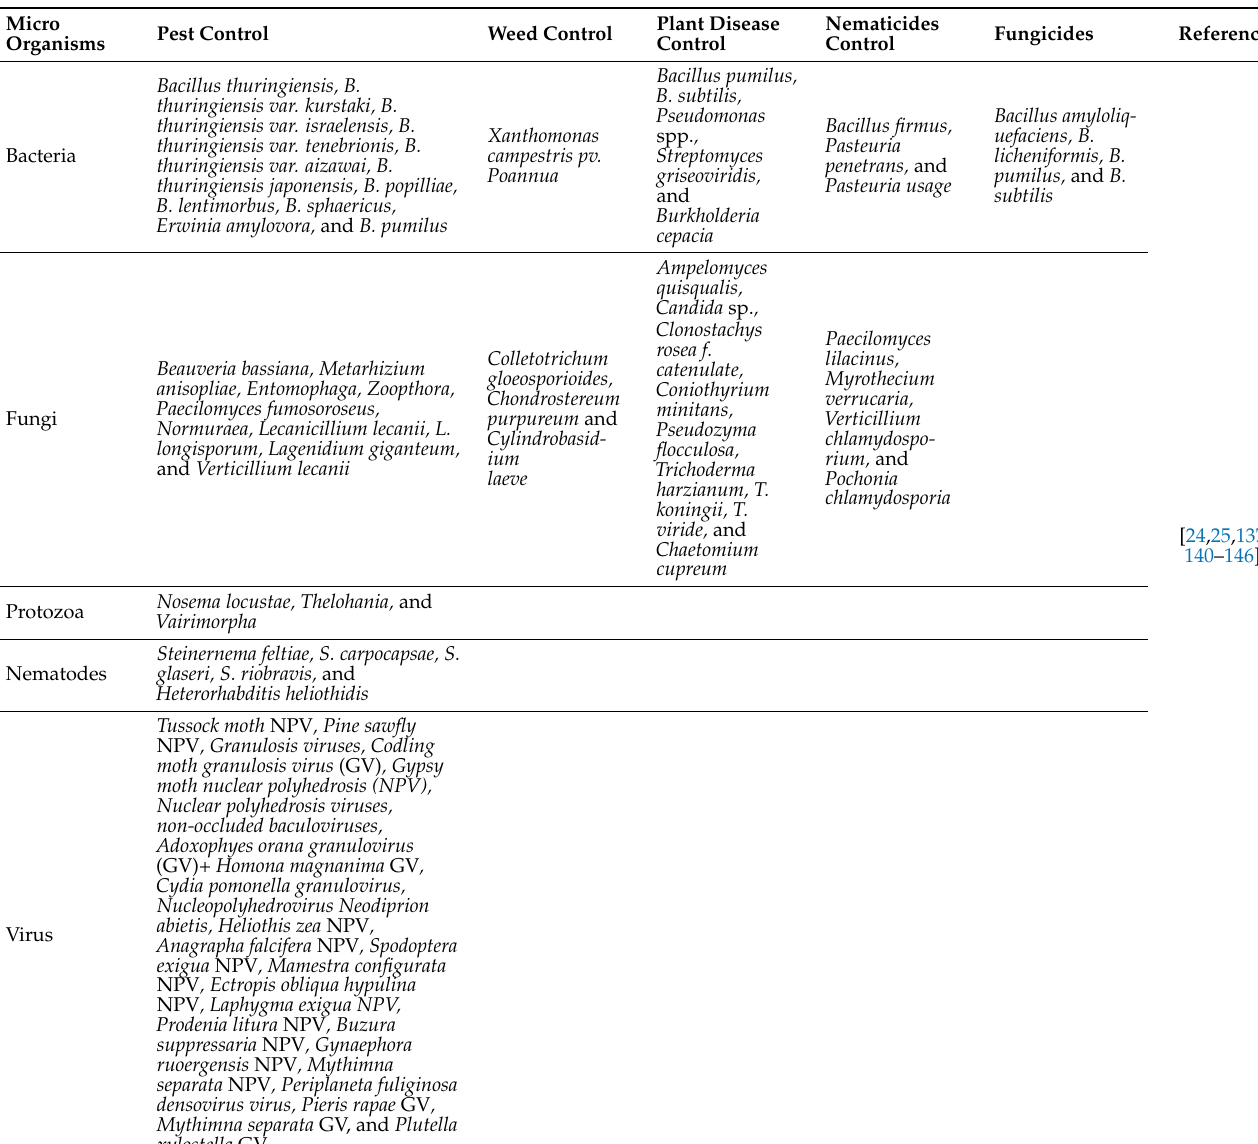
Table 6. Microbial-based